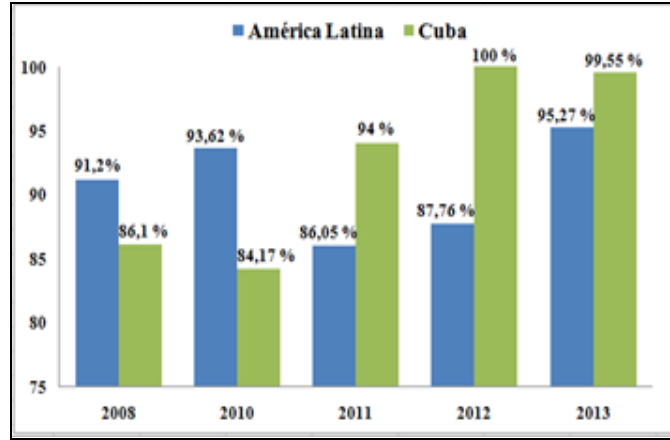
Figura 3: Disponibilidad de aceite por genérico en Cuba y América Latina .